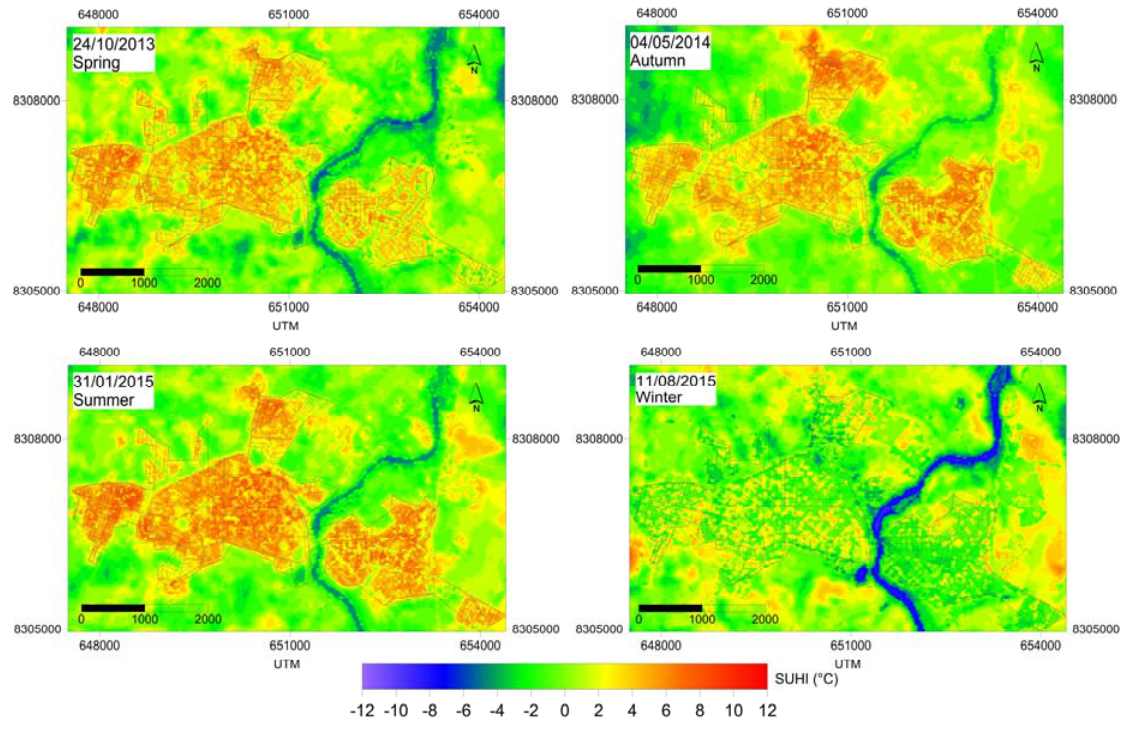
Figure 4. Seasonal variation in the intensity of SUHIs.